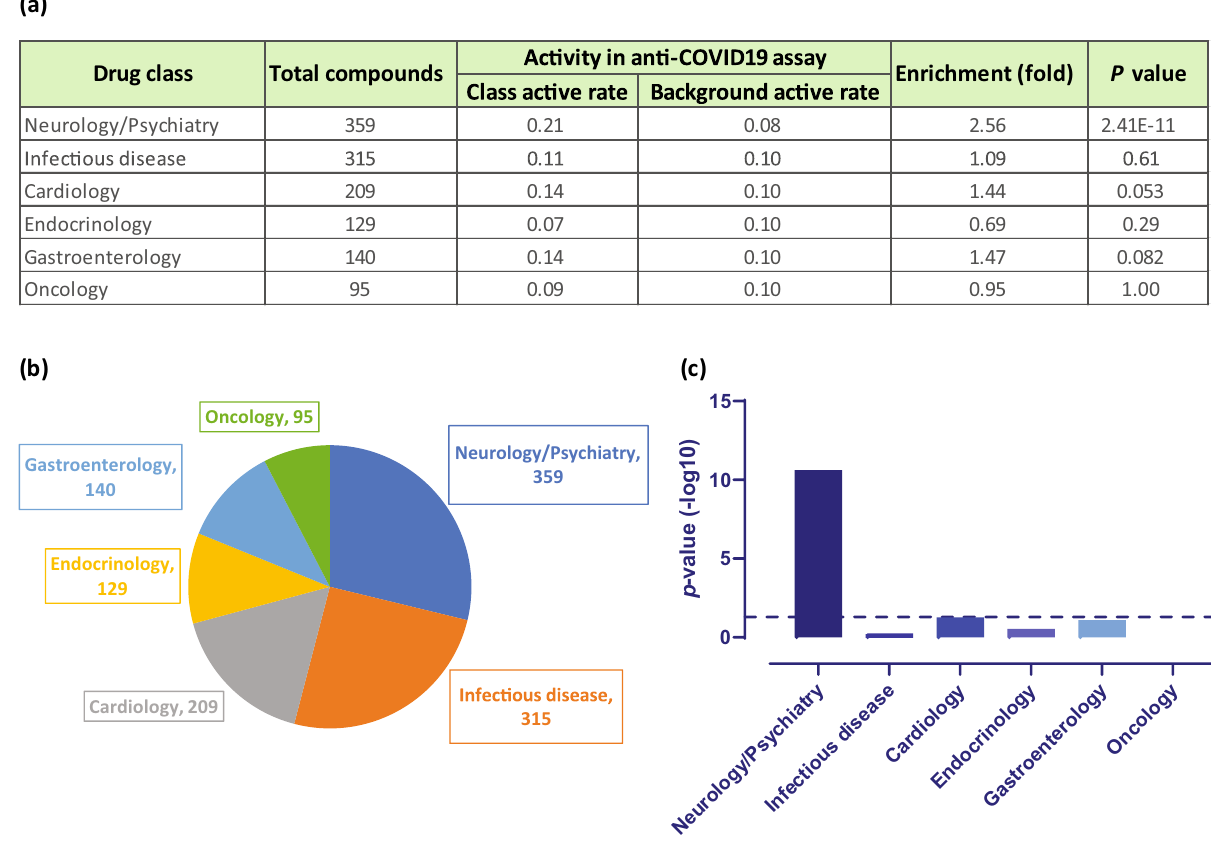
Figure 4. Enrichment of neurology/psychiatry drugs in anti-SARS-CoV-2 active compounds. (a) Activity statistics of six common drug classes in the SARS-CoV-2 CPE assay. Class active rate = Fraction of anti- SARS-CoV-2 active compounds in the drug class; Background active rate = Fraction of anti-SARS-CoV-2 active compounds outside the drug class. (b) Distribution of the six common drug classes in the NPC library. (c) Significance of enrichment of anti-SARS-CoV-2 actives in each drug class. Only the class of neurology/ psychiatric drugs was significantly enriched. The dotted line indicates the threshold for statistical